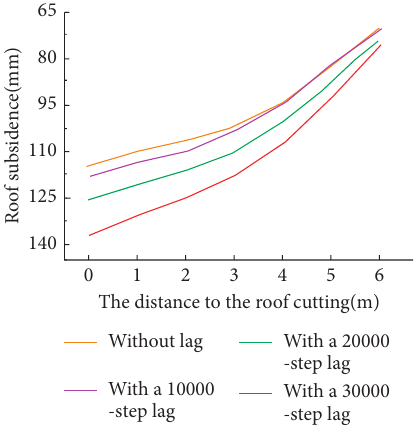
Figure 19: Vertical displacement of